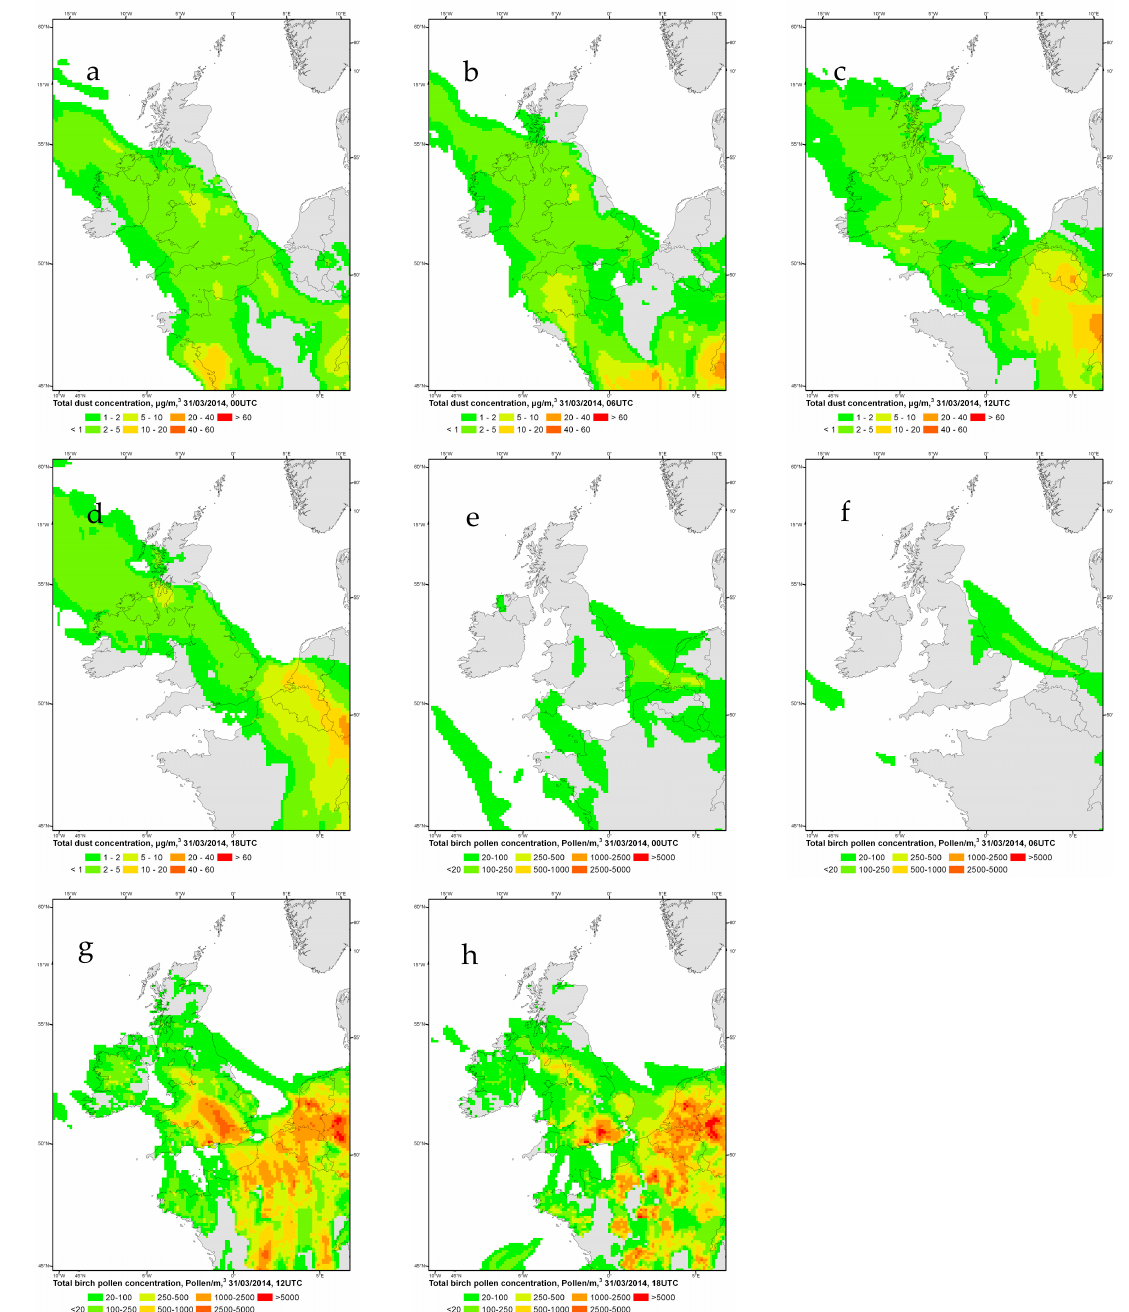
Figure 7. Calculated total dust concentrations (ug/m 3 ) ( a – d ) and total birch pollen concentration ( e – h ) (pollen/m 3 ) (all emissions included) and with radiative feedback during the central period of the episode the 31st of March 2014 with 6 h intervals going from left to right (top: dust, bottom: pollen). Overall contribution from feedback mechanisms on the daily mean concentrations are statistically significant ( p -value = 0.05) for nearly the entire model domain (Figure 8), for each of the days, noting that hour to hour concentrations vary from 0 to more than 5000 grains/m 3 depending on the location and the time of the day (Figure 7).